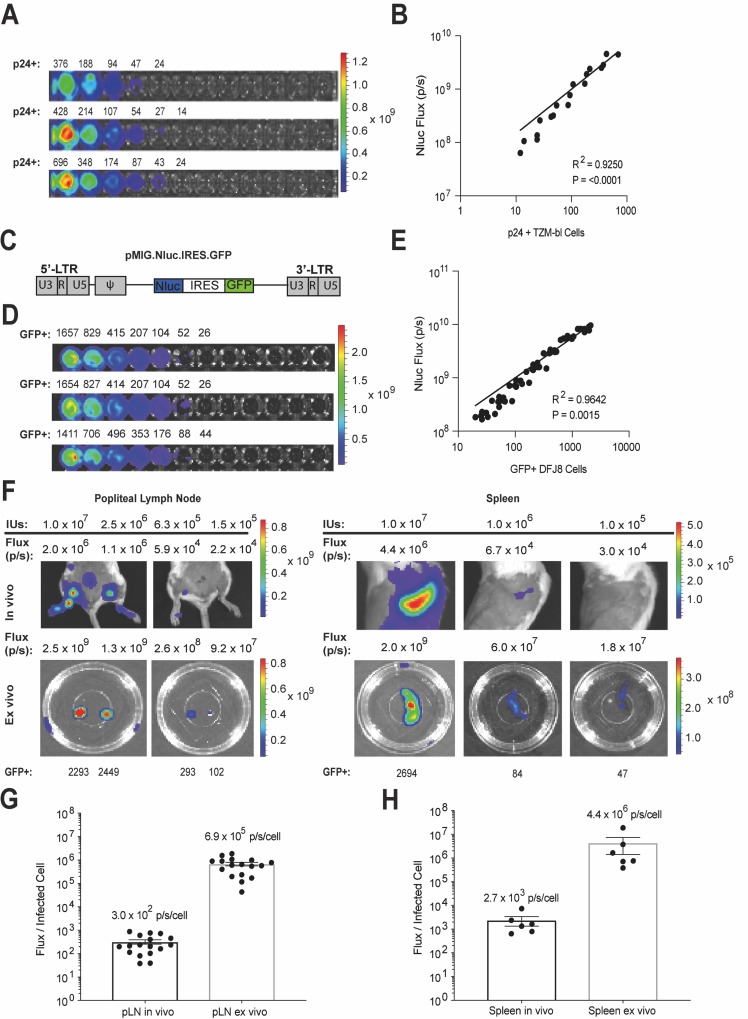
Nluc sensitivity and cellular detection limit in vitro, in vivo and ex vivo.(A-B) In vitro Nluc signal sensitivity for BG505.Nluc* infected TZM-bl cells. (A) TZM-bl cells were infected with 3.4 x 104 infectious units (IUs) of BG505.Nluc* T/F reporter virus. After 48 hours, each sample was prepared for p24 intracellular flow cytometry and then distributed in two-fold serial dilutions for IVIS imaging. The number of p24+ cells detected by flow cytometry is placed above the corresponding well analyzed via IVIS imaging. Data shown as three technical replicates from one experiment. (B) Linear regression analysis of p24 expressing cells and total Nluc signal flux (i.e. p/s) from one independent experiment. (C) Schematic of the Nluc and GFP co-expressing retroviral vector pMIG.Nluc.IRES.GFP. (D-E) In vitro Nluc signal sensitivity for Friend-MLV (F-MLV) pseudotyped pMIG.Nluc.IRES.GFP virus-infected DFJ8 cells. DFJ8 cells were infected with 5 x 105 infectious units (IUs) of F-MLV pseudotyped pMIG.Nluc.IRES.GFP virus. Infected cell cultures were resuspended in 150 μl of PBS and then subsequently divided into 50 μl and 100 μl aliquots. The number of infected cells in the 50 μl aliquot (i.e. GFP+ cells) were determined by flow cytometry and the 100 μl aliquot was then serially diluted two-fold on a 96 well plate and imaged using an IVIS Spectrum instrument after adding Nano-Glo Nluc substrate at a final ratio of 1:40. Data shown as three representative technical replicates from one of three independent experiments (n = 3). (E) Linear regression analysis of GFP expression and Nluc signal flux (i.e. p/s) in infected DFJ8 cells from three independent experiments. (F) In vivo and ex vivo Nluc signal detection limit in BALB/c mice infected subcutaneously via the footpad as well as intravenously via the retro-orbital route with decreasing concentrations of Friend MLV pMIG.Nluc.IRES.GFP virus for delivery to the popliteal lymph node and spleen, respectively. GFP expressing cells were assessed via flow cytometry from cell suspensions generated from tissues following bioluminescent imaging. (G-H) Ratio of total Nluc flux to GFP expressing infected cells for the (G) popliteal lymph node (n = 16) and (H) spleen (n = 6) imaged both in vivo and ex vivo. Average flux/infected cell ratios are shown above for each imaging condition and each organ. Data shown as mean +/- SEM of 6–16 independent organ preparations.